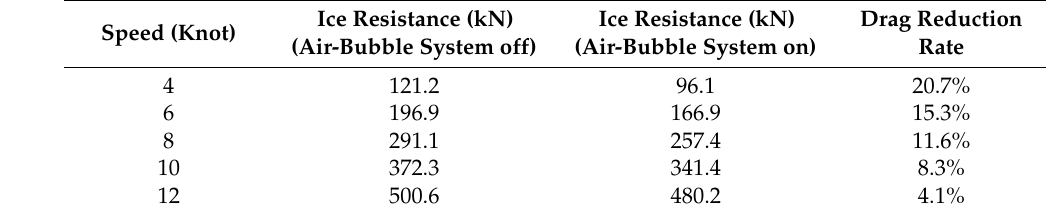
Table 4. Ice resistance at different speeds.